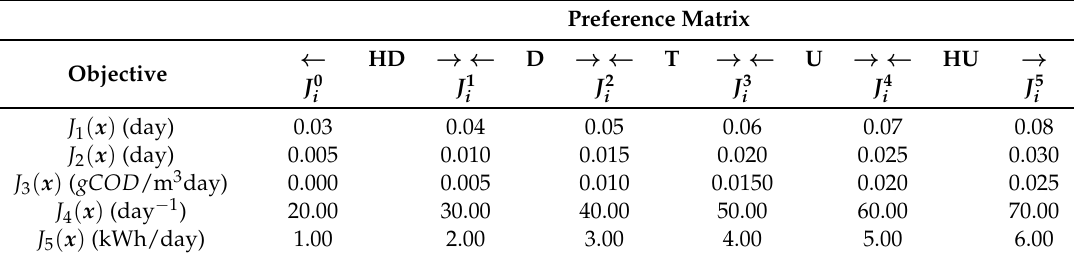
Table 5. Preference matrix m for MOP statement I. Five preference ranges have been defined: highly desirable (HD), desirable (D), tolerable (T) undesirable (U) and highly undesirable (HU).